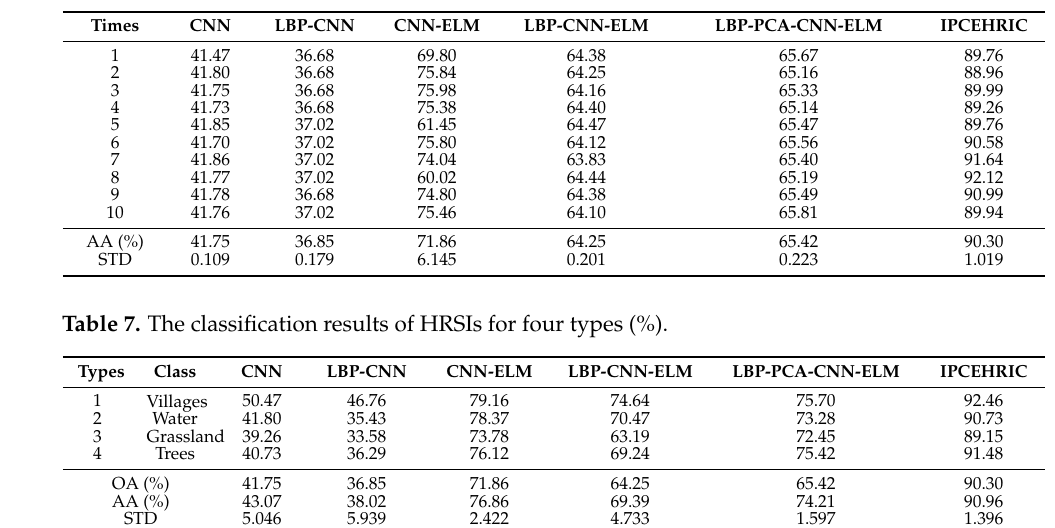
Table 6. The classification results of HRSIs for 10 times for four types (%).